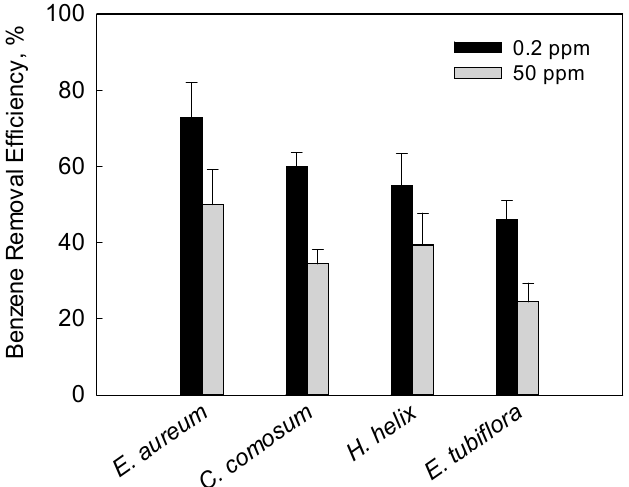
Figure 5. Comparison of benzene removal efficiency of the four plants after being exposed to 0.2 ppm and 50 ppm of benzene. The error bar indicates the standard deviation for three replicates.